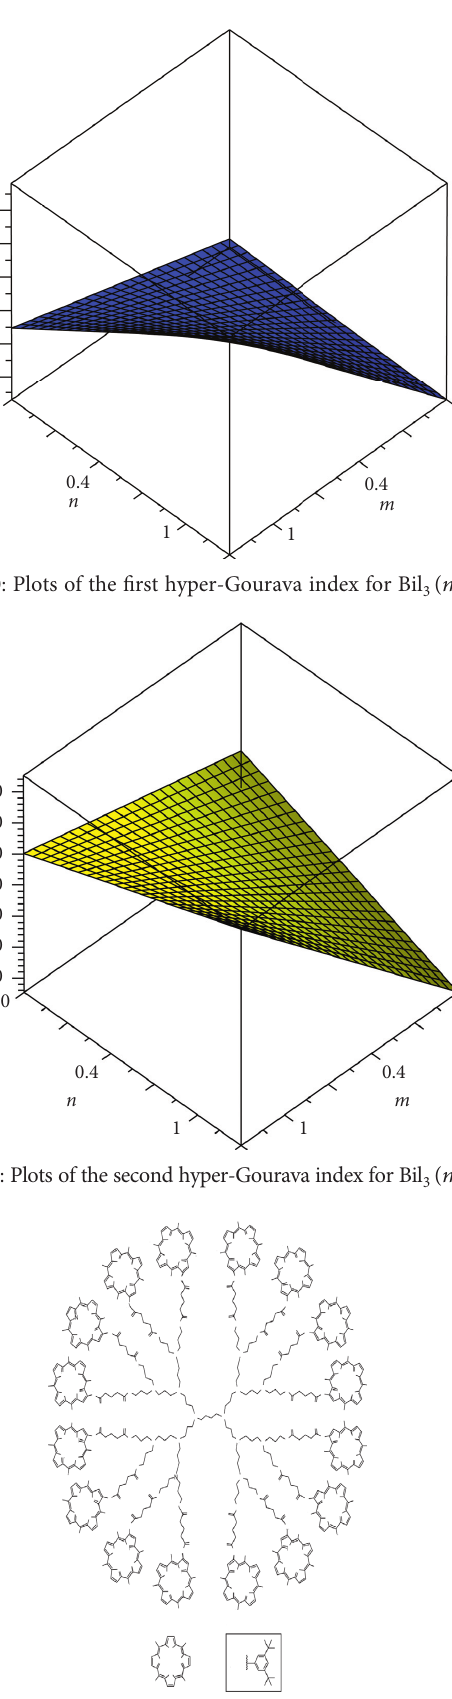
Figure 32: Porphyrin dendrimer D